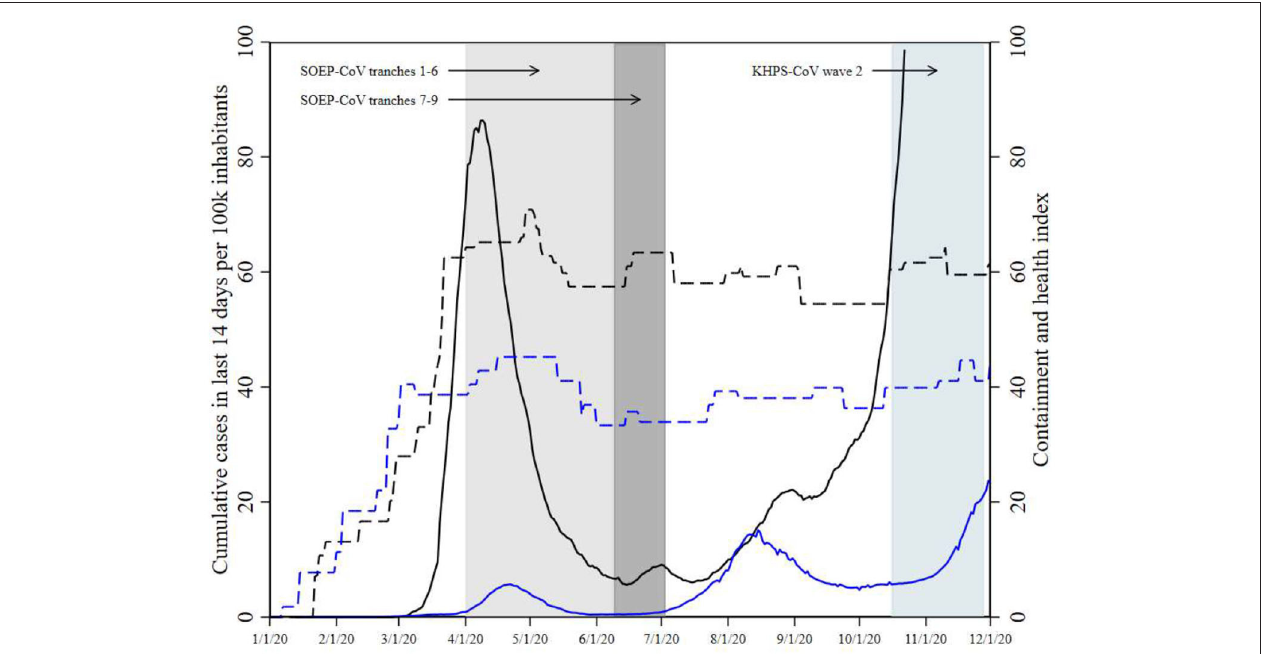
FIGURE 1 | COVID-19 infections and government response during the survey periods. Data are from Nippon Hoso Kyokai, Robert-Koch Institut, and (2). Japanese data are in blue, German data in black. Solid lines indicate COVID-19 infections, dashed lines indicate the containment and health index. German infection data are only shown up to a value of 100 to ease comparison to the Japanese data. Fieldwork for SOEP-CoV was conducted in several tranches staggered over time, each representing a random sample. Tranches 7-9 of SOEP-CoV are shown separately (see Section 2), as attitudes toward vaccination were only surveyed only in these